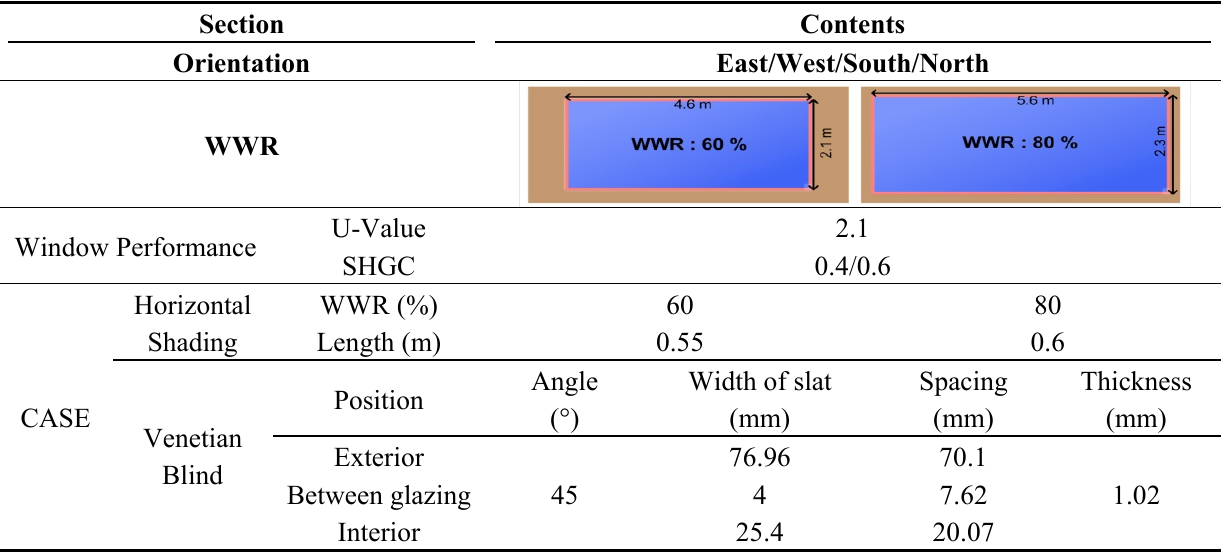
Table 5. Simulation parameter and details of various